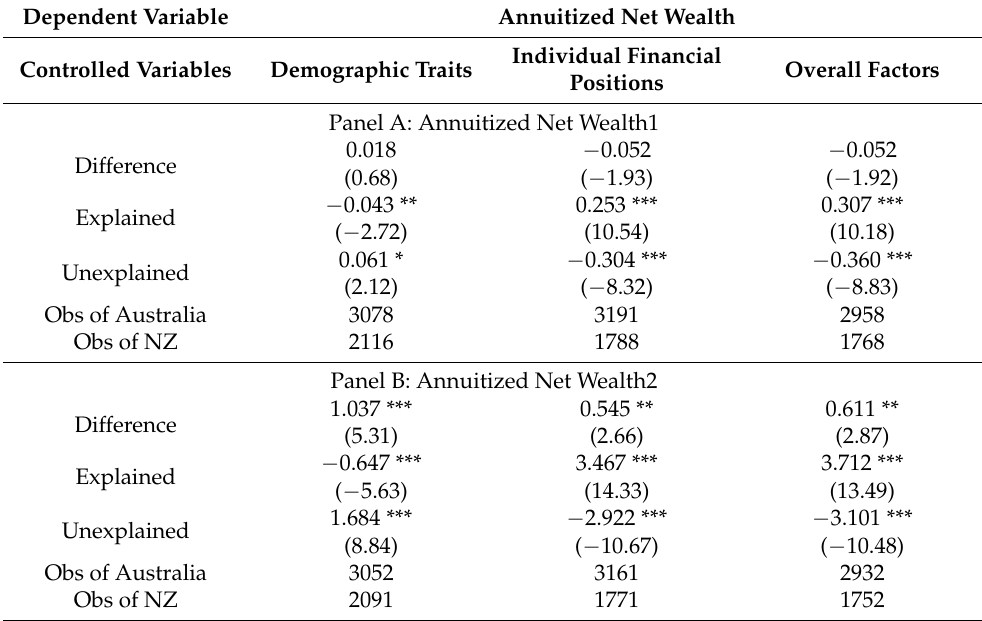
Table 11. Other distributional decomposition methods (bottom